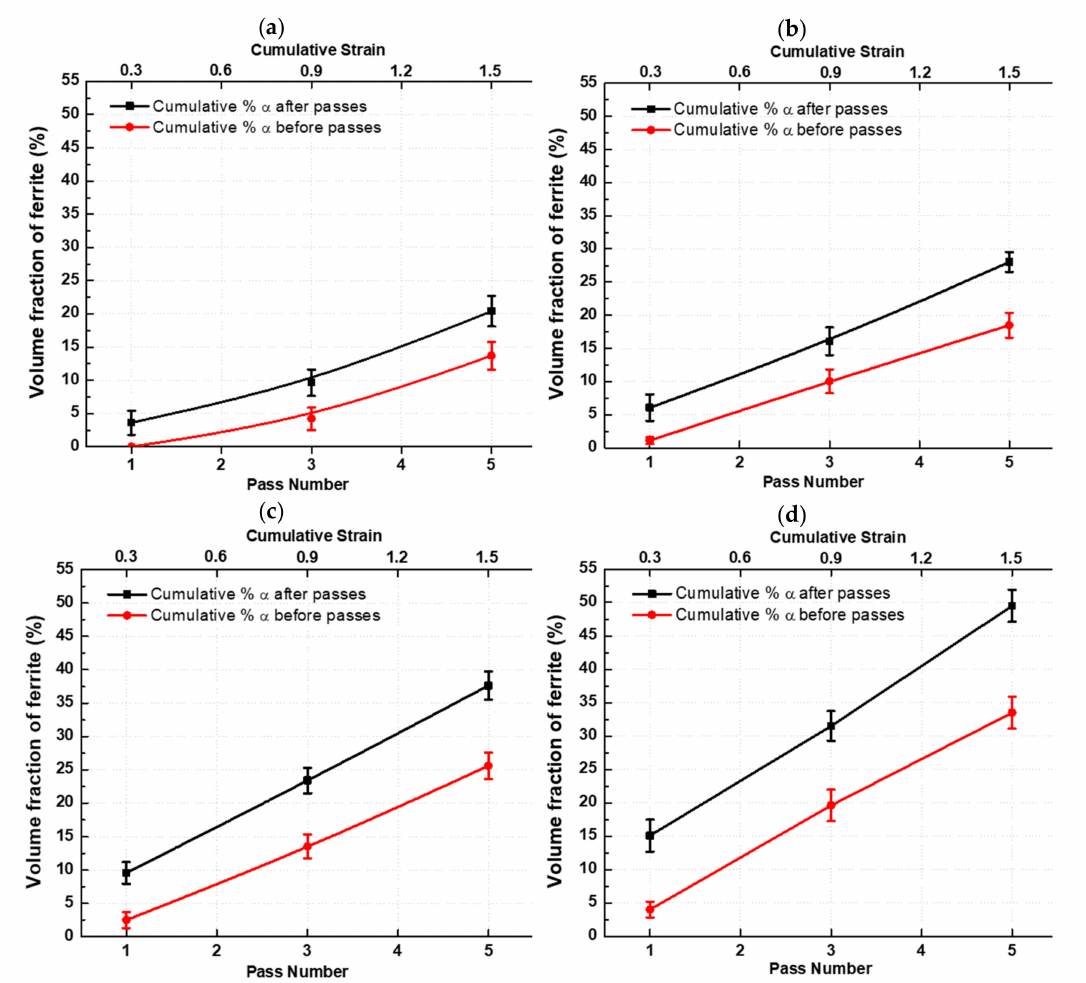
Figure 8. The dependence of the cumulative volume fraction of ferrite formed and retained on finishing pass number after roughing pass number of: ( a ) zero, ( b ) one, ( c ) two and ( d ) three. More ferrite was formed in the simulations with higher numbers of roughing